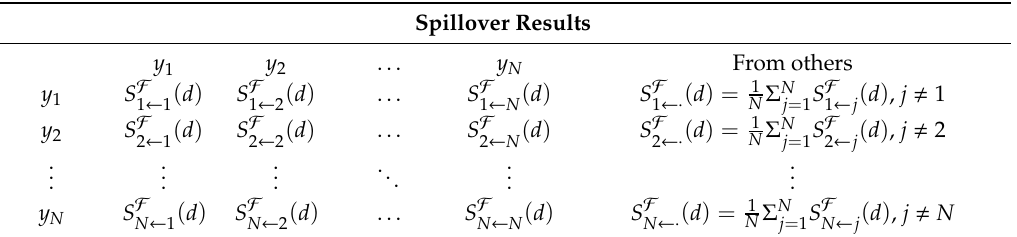
Table 2. The spillover table of the Barunik–Krehlik methodology (2018).